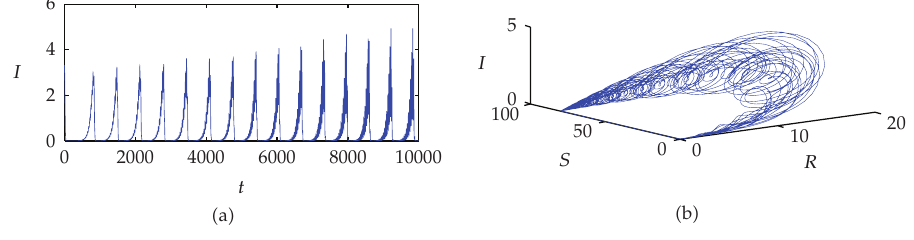
Figure 2: The parameters like in Figure 1 but τ (cid:8)